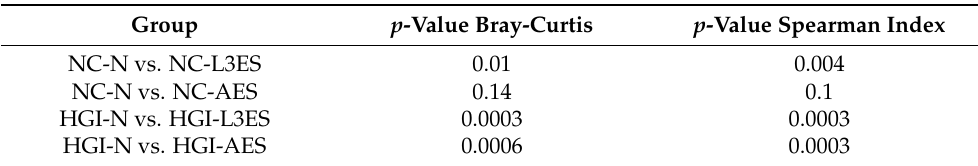
Table 1. Significant differences in alpha diversity based on Adonis p -values determined using Bray-Curtis and Spearman index